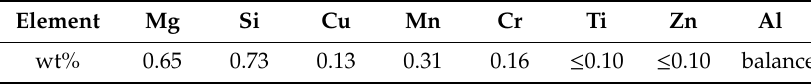
Table 1. The nominal composition of